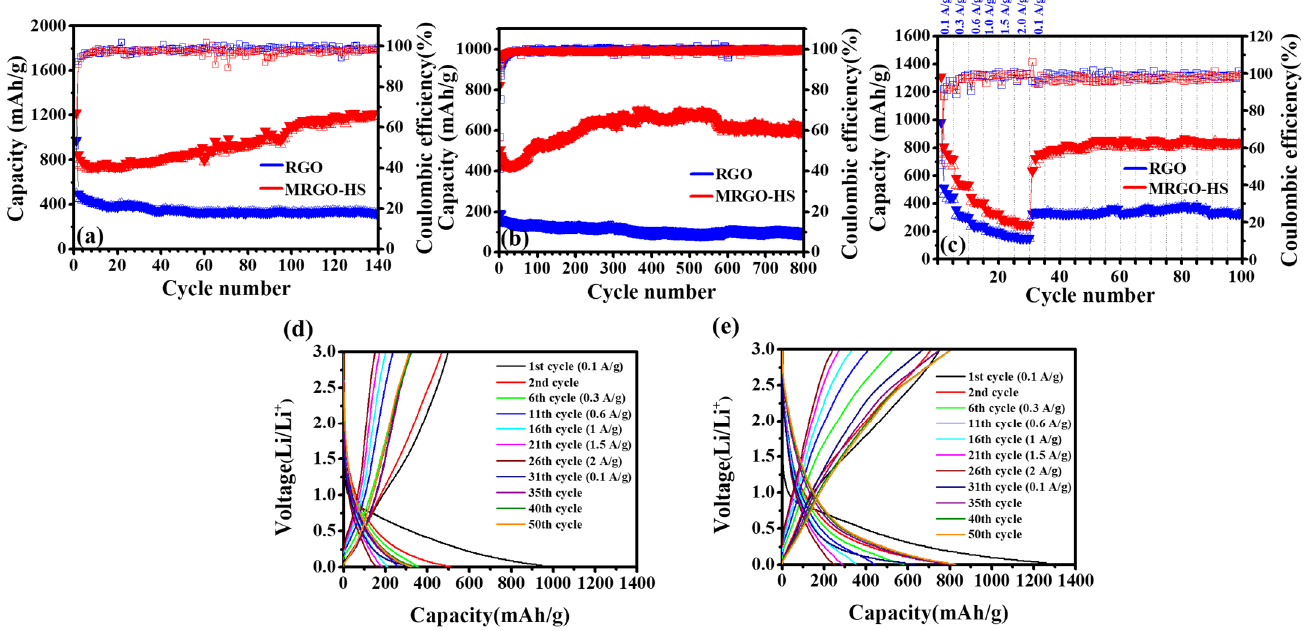
Figure 11. ( a ) Cycling performance and coulombic efficiency of RGO and MRGO-HS (at the current density of 0.1 A/g), ( b ) at the current density of 1 A/g, ( c ) at various current densities. Galvanostatic charge/discharge curves of ( d ) RGO, and ( e ) MRGO-HS between 0.01 and 3.0 V at various current densities.